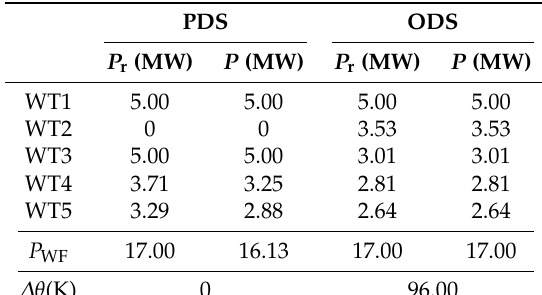
Table 5. Comparison of power and temperature rise in Case 3, M2.